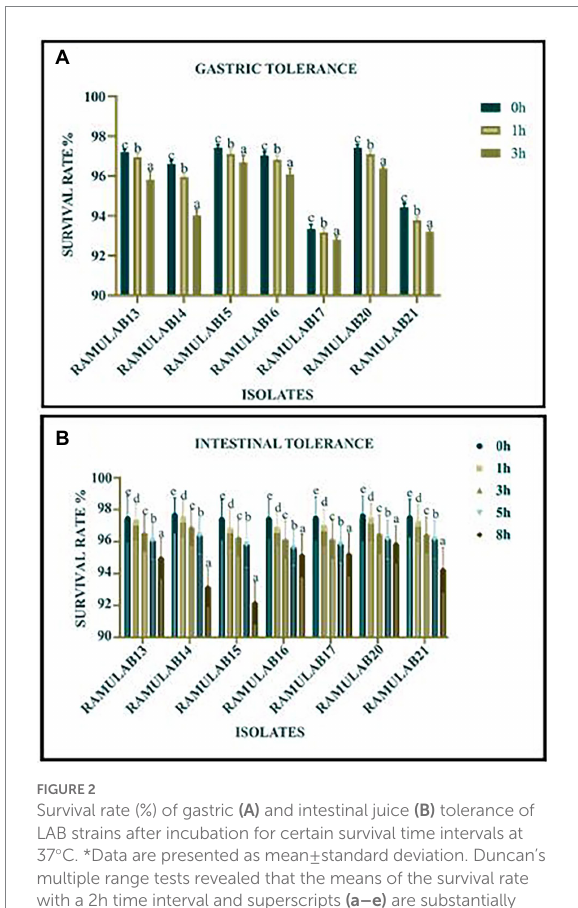
FIGURE 2 Survival rate (%) of gastric (A) and intestinal juice (B) tolerance of LAB strains after incubation for certain survival time intervals at 37 ° C. *Data are presented as mean ± standard deviation. Duncan’s multiple range tests revealed that the means of the survival rate with a 2 h time interval and superscripts (a–e) are substantially different from one another ( p ≤ 0.05).